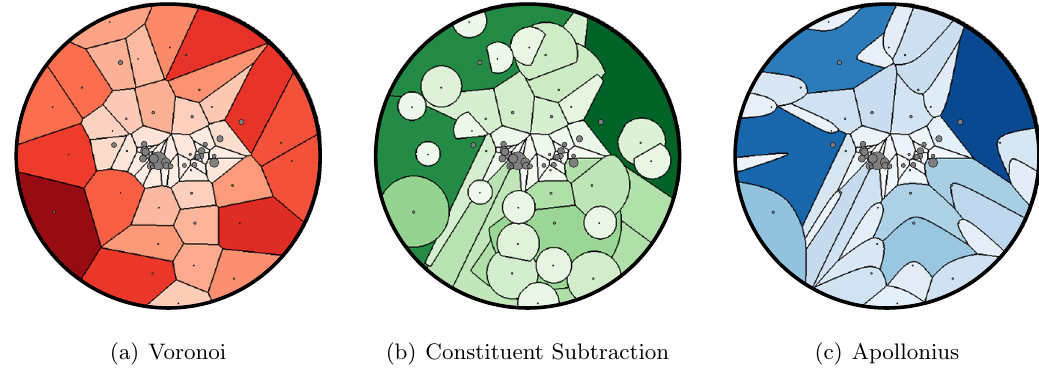
Figure 9 . Three pileup subtraction procedures shown for a jet from the 2011A CMS Jet Primary Dataset. The jet constituents are shown as gray disks at their locations in the rapidity-azimuth plane with sizes proportional to their transverse momenta. The boundary is at a distance R = 0 : 5 from the jet axis at the center. The color intensity of each region is proportional to its area, which determines the size of the pileup correction. The Voronoi diagram (a) is independent of (cid:26) . The constituent subtraction (b) and Apollonius (c) diagrams are determined using a (cid:26) that corresponds to subtracting one-tenth of the total scalar p T of the